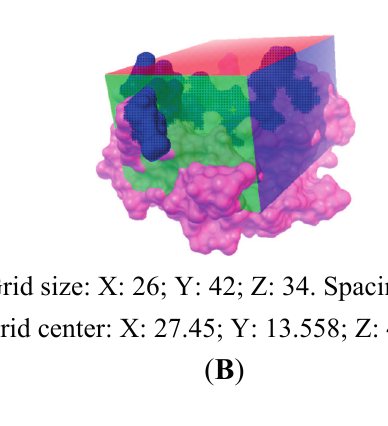
Figure 2. Docking result of compound 3 generated by AutoDock4 and viewed by PyMol. ( A ) Docking pose of compound 3 into Pf Fd. The magenta color is the surface of amino acid residues of Pf Fd involved in the interaction with Pf FNR, ( B ) Grid box used in docking experiment into maize leaf-FNR. Dark blue color is the surface of active amino acid residues in the interaction with maize leaf-Fd, ( C ) docking pose of compound 3 on maize-FNR and attached by maize-Fd. Yellow: maize leaf-FNR, red: maize leaf-Fd, and blue: compound 3